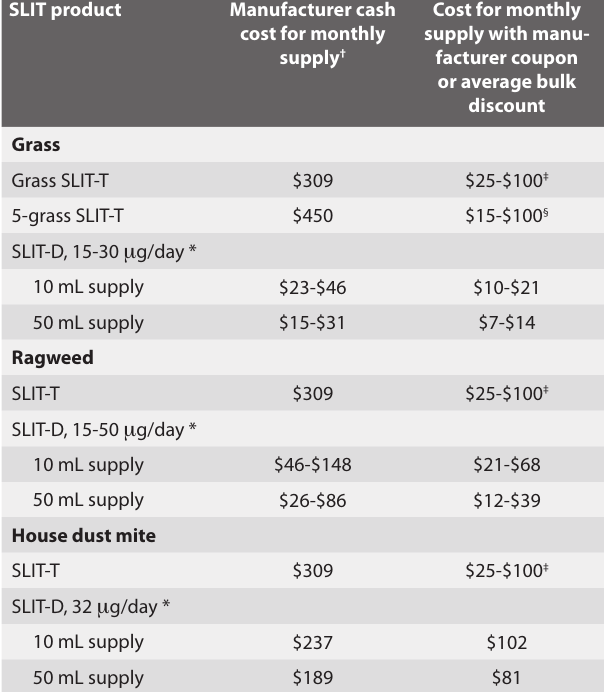
Table 4. Cost of monthly supply of SLIT-T and SLIT-D in the United States. SLIT-D daily doses are those recommended by Leatherman et al. (13)